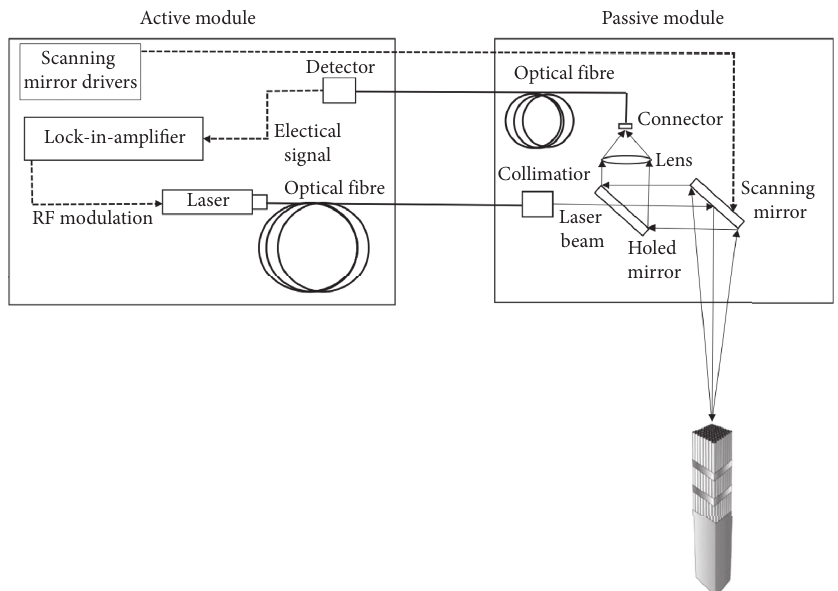
Figure 2: Scheme of the ENEA radiation tolerant AM 3D laser imaging system.